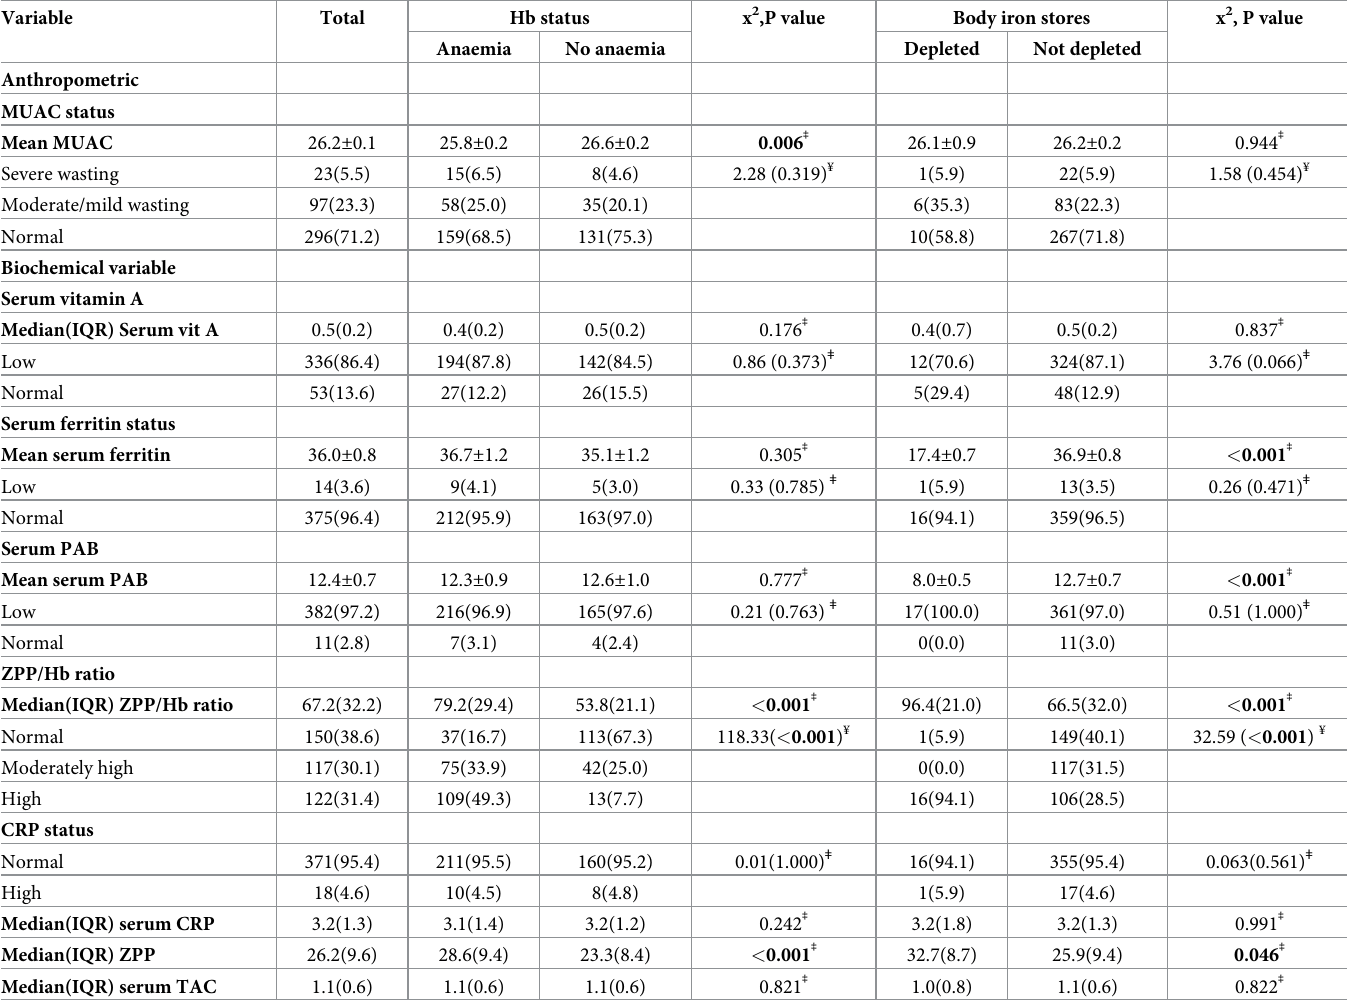
Table 2. Relationship between MUAC status, biochemical parameters and iron deficiency anaemia